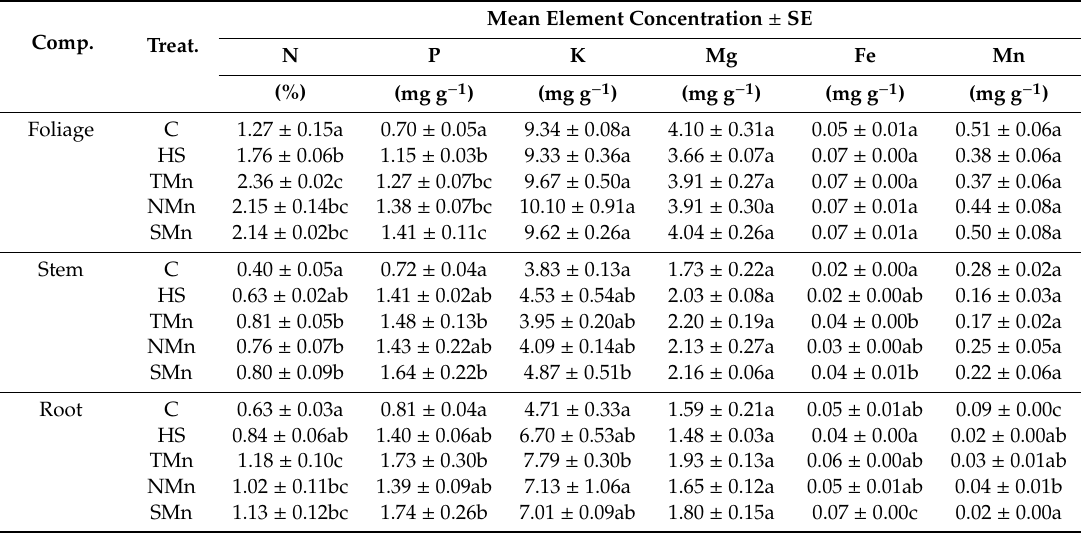
Table 4. E ff ect of manganese fertilization treatments 1 (Treat) on the mean 2 elemental content of 12-week-old northern red oak ( Quercus rubra L.) seedlings by component (Comp). Comp.